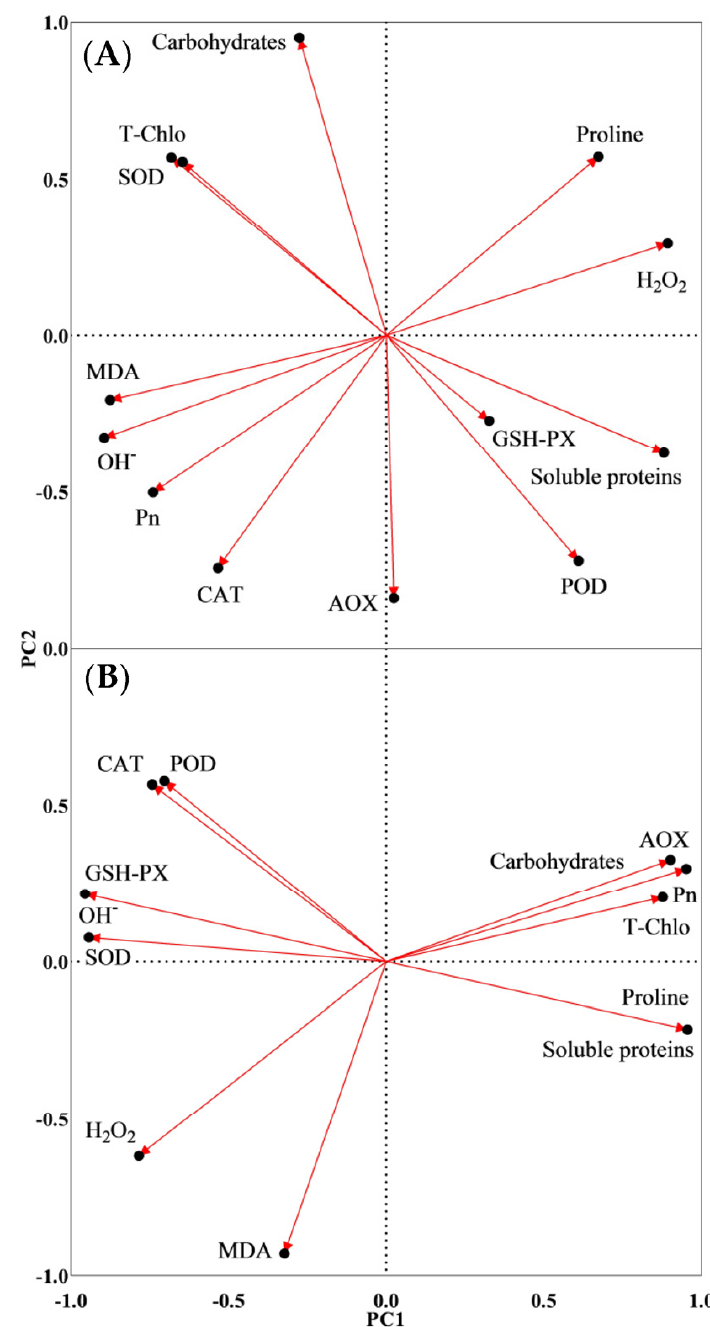
Figure 7. Loadings plot of the PCAs showing correlation between antioxidant enzymes, osmolytes, ROS, MDA, and proteins in control group CoH1 ( A ) and CoH2 ( B ). The correlation profile of the data was not similar based on the type of variety